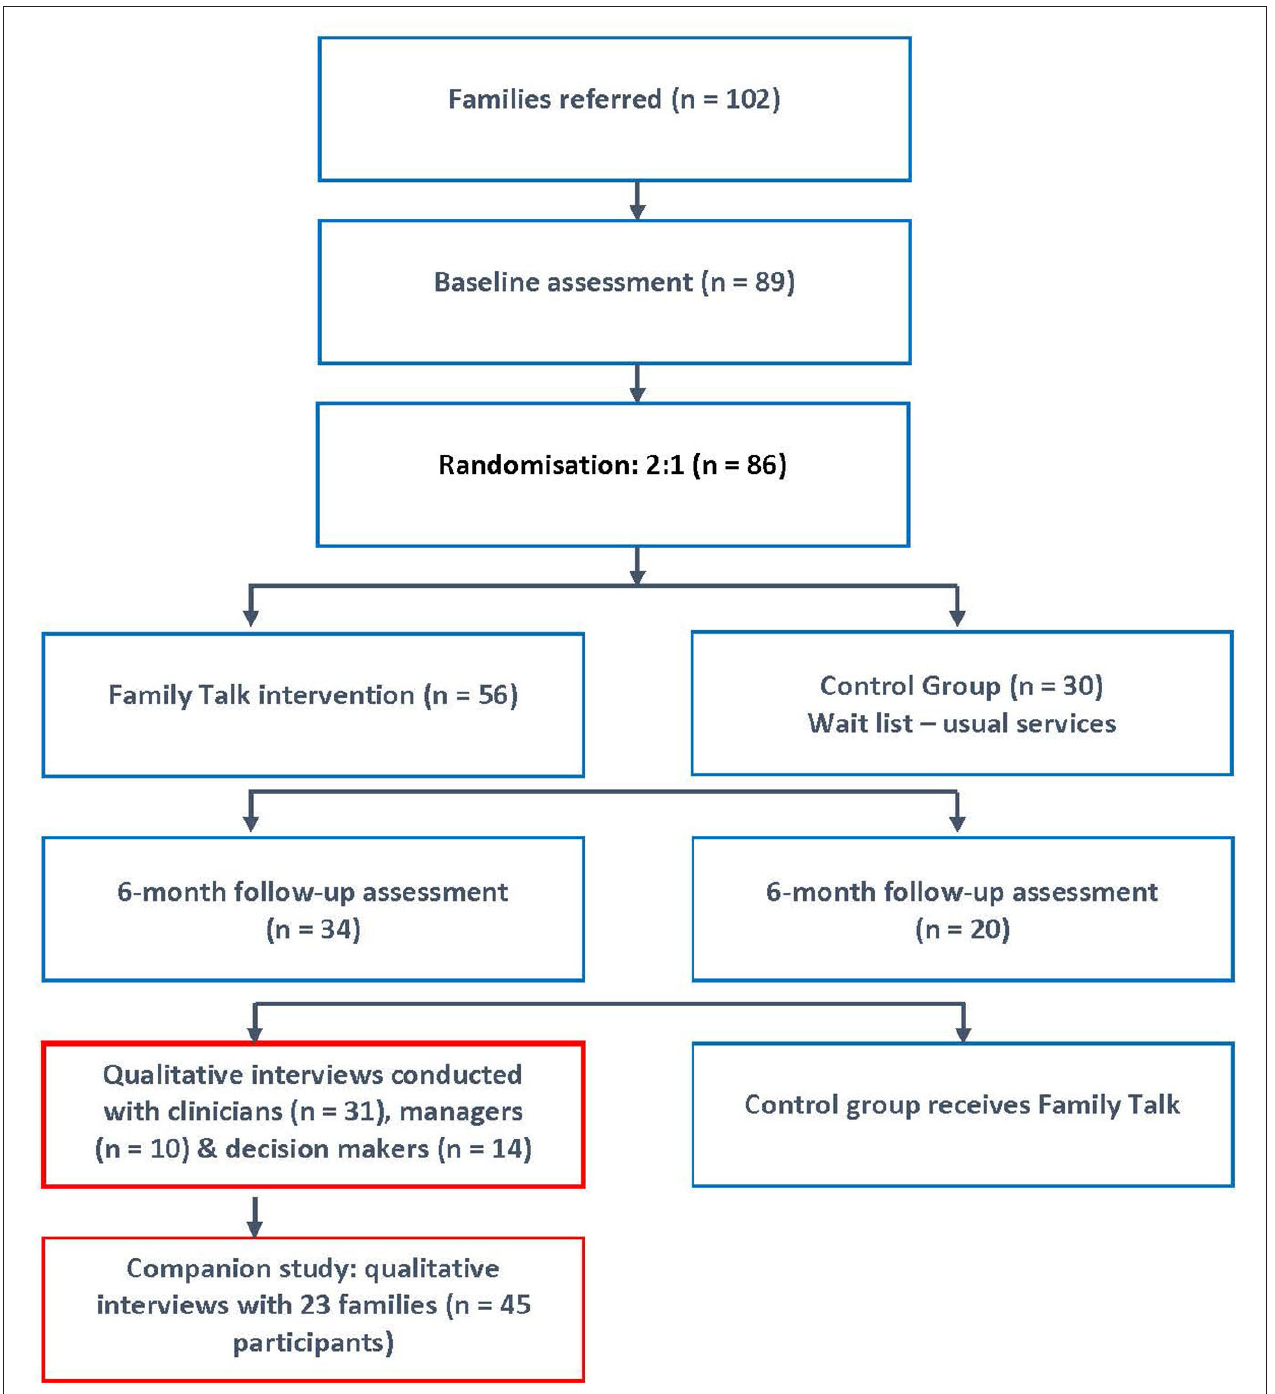
FIGURE 1 | Study flow diagram from RCT to qualitative